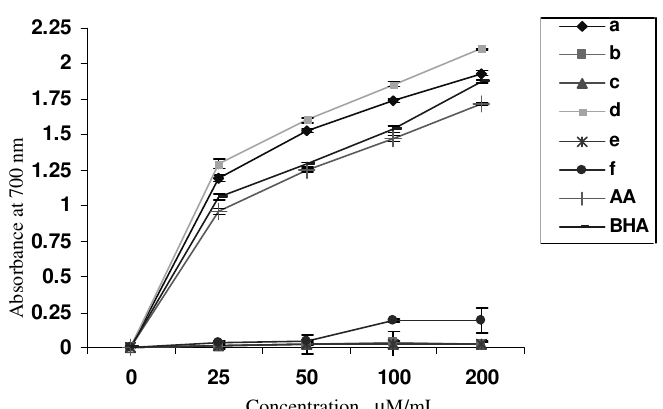
Figure 3. Antioxidant activity of the dibenz[ b,f ]azepine and its derivatives at different concentrations using reducing power assay. Each value represents means ± SD (n=3). High